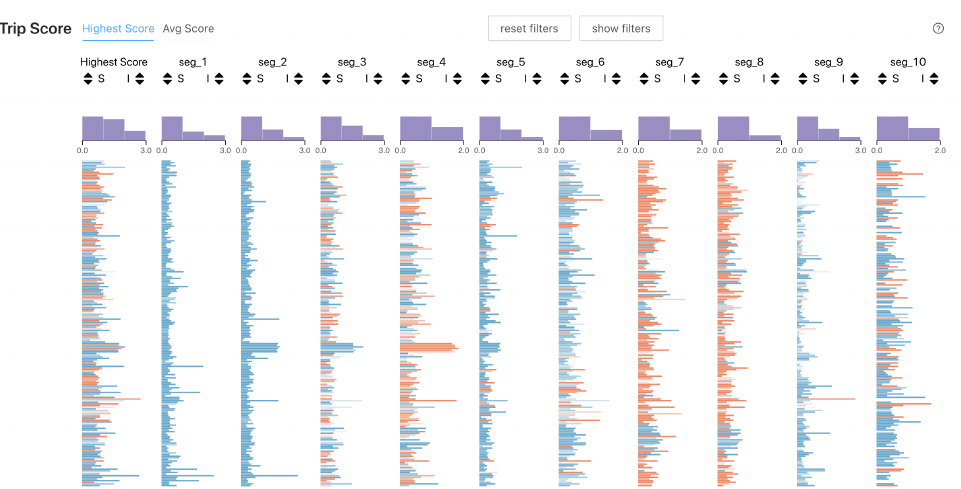
Figure 7. An example with the data displayed on the score table for Scenario 1. The user was asked three questions regarding the number of outliers, identification of the most anomalous trip, and spatial regions containing more